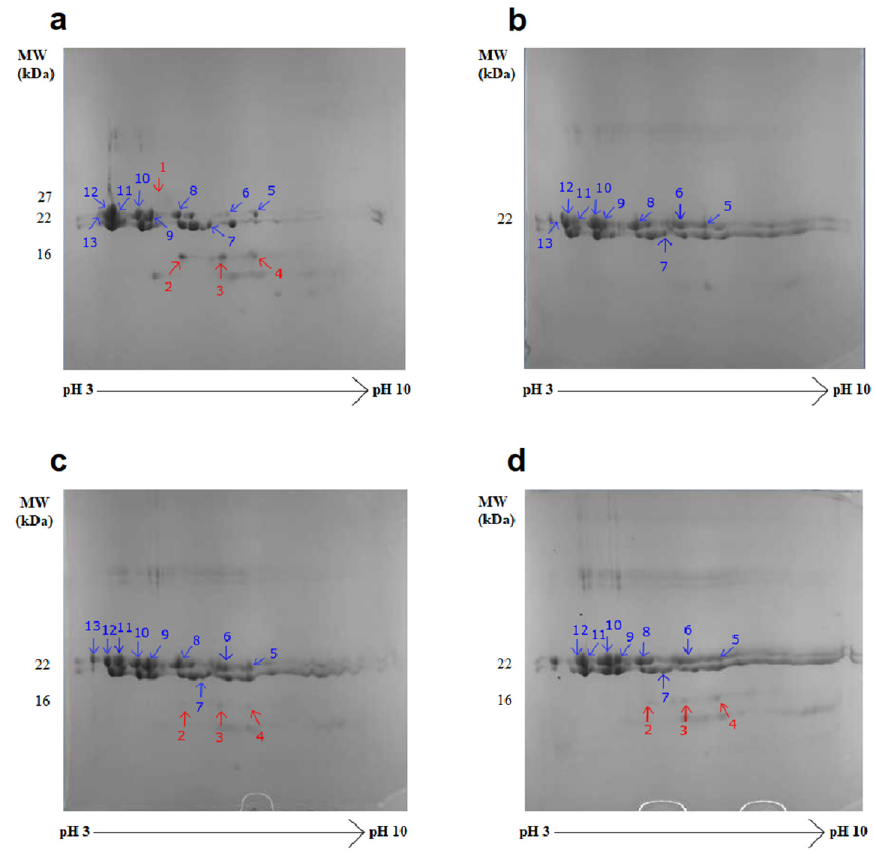
Figure 4. Detection of zein proteins. The proteins from fresh corn ( a ), high-moisture corn ensiled with inoculant Lactiplantibacillus plantarum ( b ), lactic acid ( c ), and without additives ( d ) were separated on 2-DE using linear immobilized pH gradient strips (17 cm, pH 3–10) in the first and 12% polyacrylamide gels in the second dimension. All visible spots were excised from the gels and analyzed by mass spectrometry. Identified γ -zein protein spots are indicated by red numbers and other zein protein spots by blue numbers. The numbers correspond to zein proteins defined as in Figure 3b.